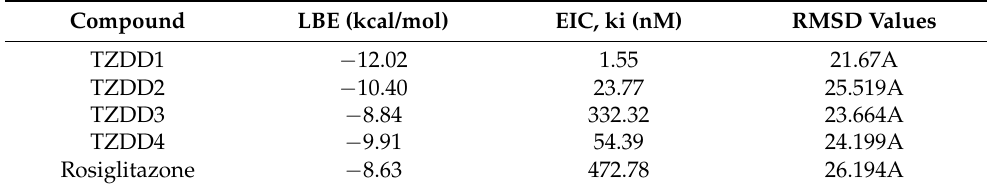
Table 3. Low binding energies (LBE), estimated inhibition constants (EIC), and root-mean square deviations (RMSD) values of the TZD derivatives from the docking studies, temperature at 298.15 K.